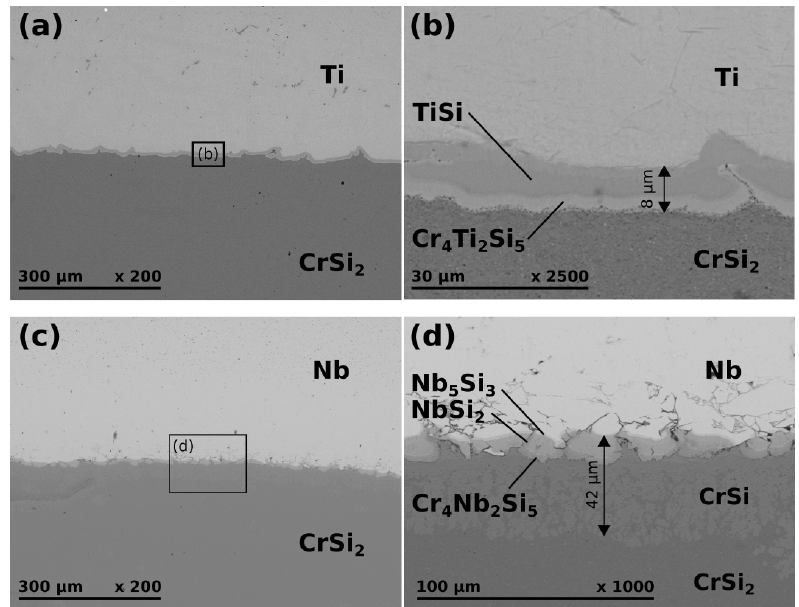
Figure 4. SEM back-scattered images showing the microstructure of the contact interface after SPS sintering. The images ( a , b ) and ( c , d ) show the Ti–CrSi 2 and the Nb–CrSi 2 interfaces, respectively, at different magnifications. The chemical composition of the different phases was determined by EDS